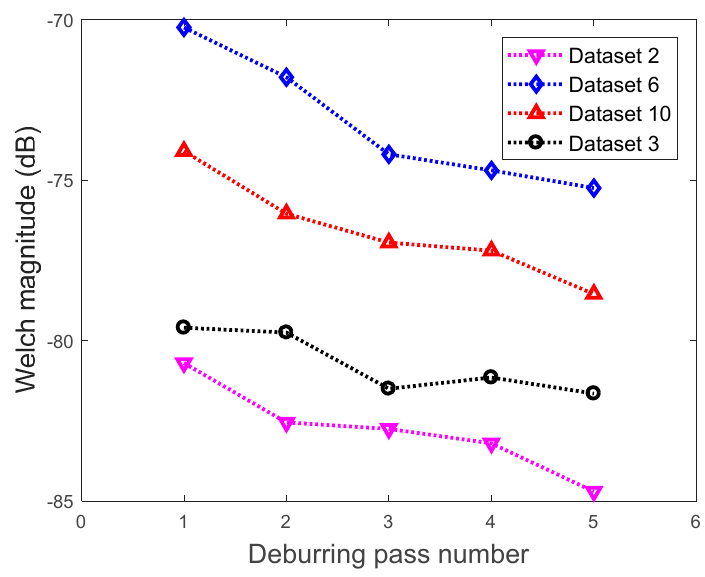
Figure 20. The representative plot of four datasets.